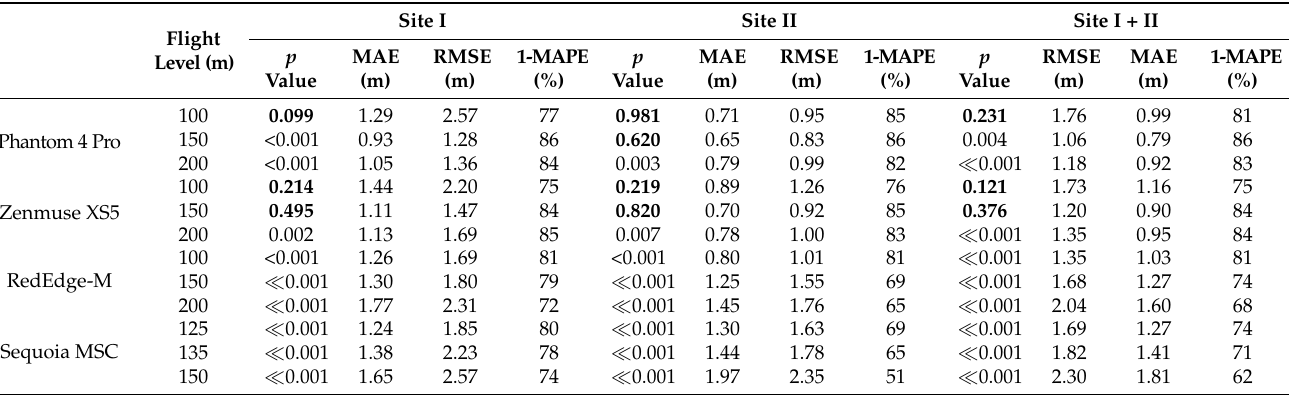
Table 4. Tree crown delineation: p values of Student’s t -test or Wilcoxon test, descriptive Mean Absolute Error (MAE) and model performance (1-MAPE). Non-significant values are in bold—such models are supposed not to differ from the reference value.